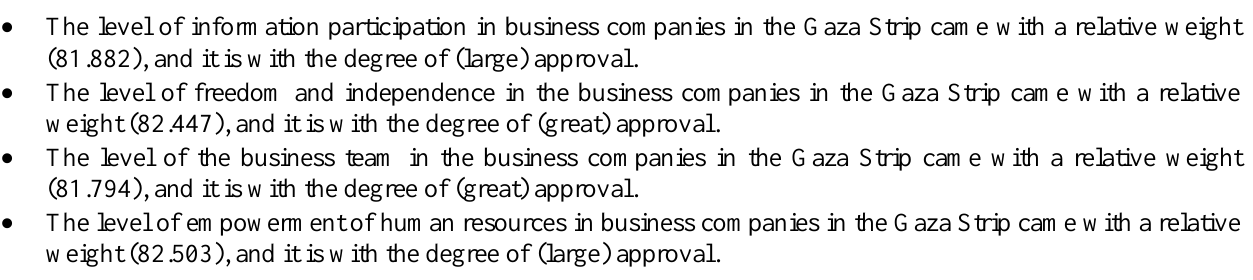
Table 13. Analysis of the Paragraphs of the Participation Axis with